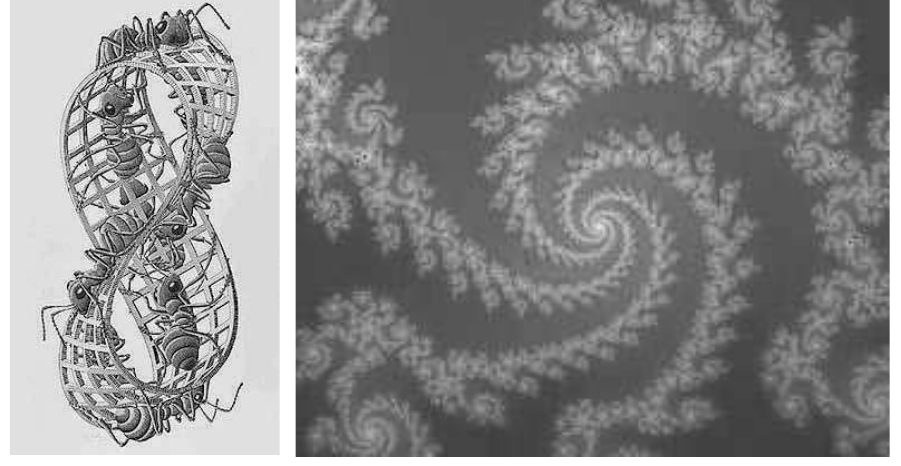
Figure 4. Moebius Strip II (M. C. Escher) Source: http://www.mce- scher.com/.